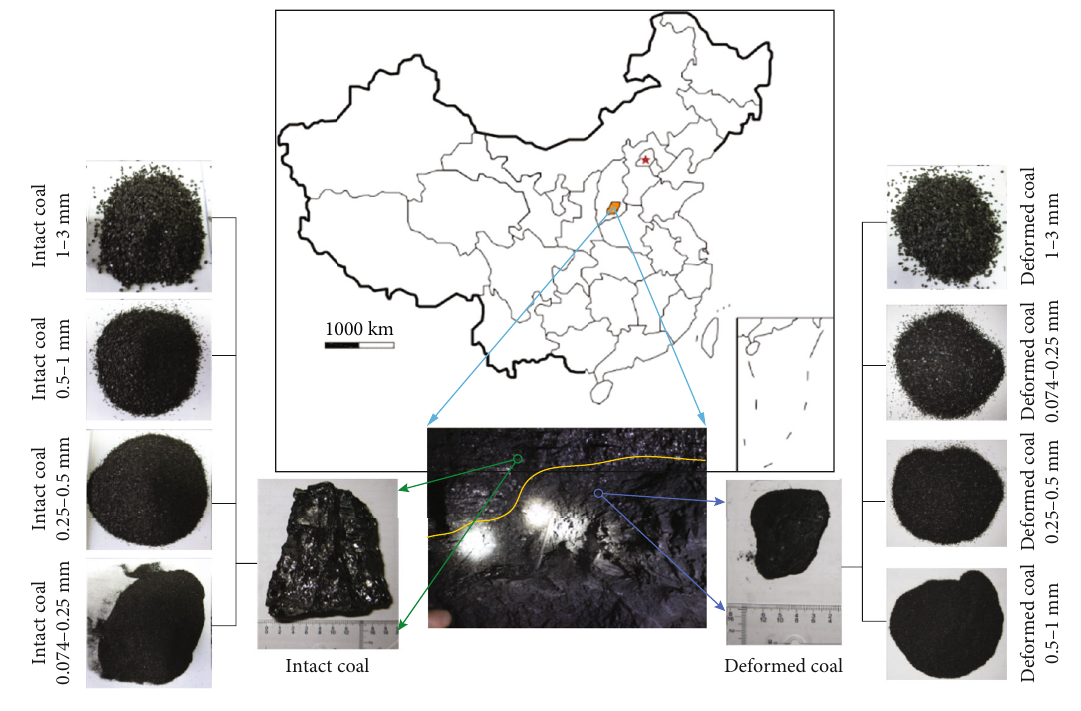
Figure 1: Sampling sites and coal samples. Table 1: Basic physical parameters of coal